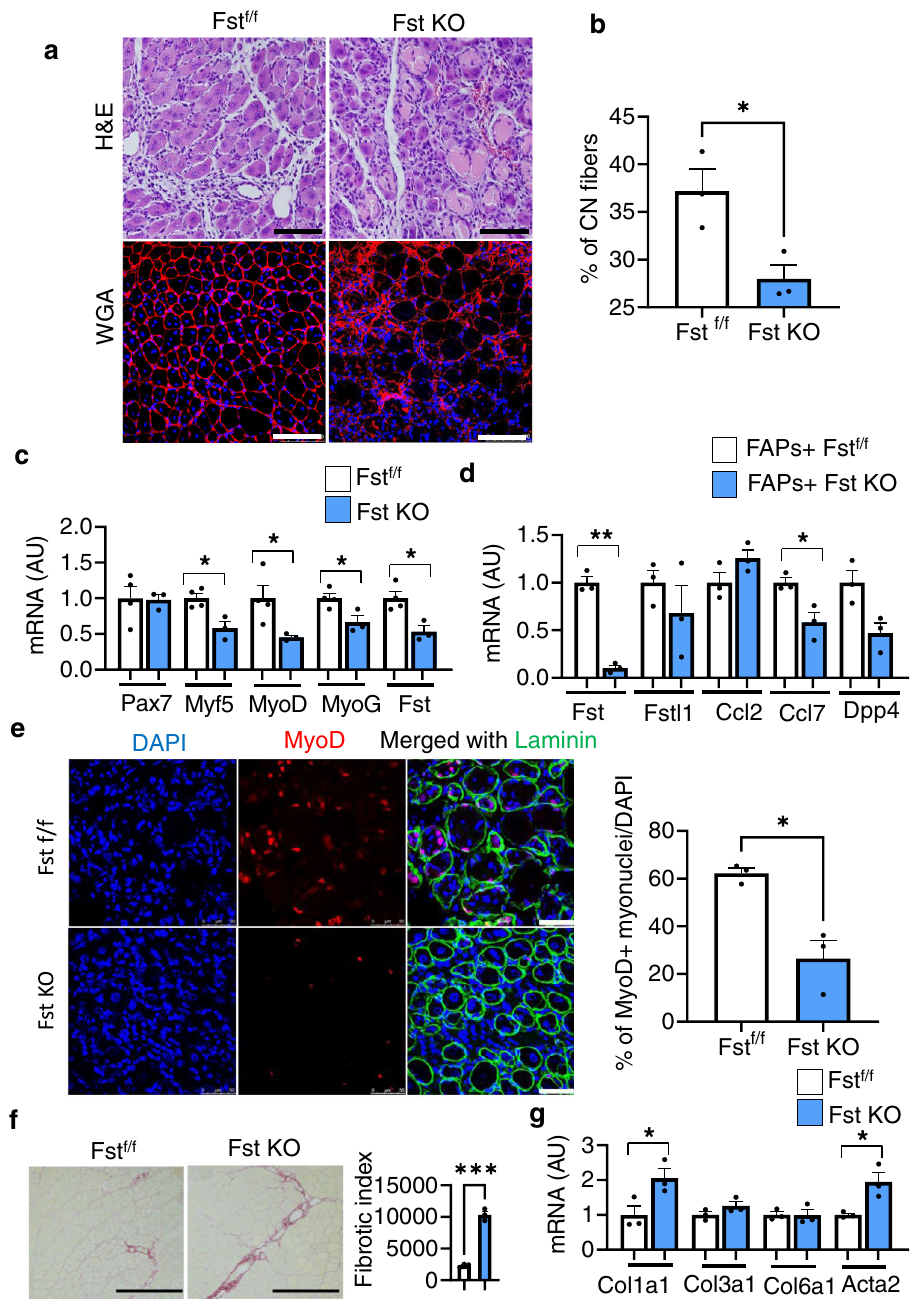
Fig. 3 | DepletionofCD206 + M2-likeM Φ speci fi cally enhancesFAP-derivedFst. a Histological sections of Gc muscle from FAP-derived Fst KO and Fst f/f control mice, harvested at 7 dpi, stained with H&E (upper) or WGA and DAPI (lower) ( n =3 mice per group). Scale bar, 200 μ m (H&E) and 100 μ m (WGA). b Images stained withDAPIandWGAwereusedtoquantifycentrallynucleated(CN) fi bersofmuscle from FAP-derived Fst KO and Fst f/f control mice. Quanti fi cation of CN myo fi bers (cross-sectional areas (in µ m 2 ) of the Gc muscle) ( n =3 mice per group). c Relative mRNAexpressionofmyogenesis-relatedmarkergenesinmuscleofFAP-derivedFst KOmice,comparedwiththeirlittermatecontrols. n =4(Fst f/f ),and3(FstKO)mice. d Relative mRNA expression of activated FAP-related marker genes in FACS- isolated FAPs of FAP-derived Fst KO mice, compared with their littermate control Fst f/f mice ( n =3 mice per group). e Representative images of frozen sections of